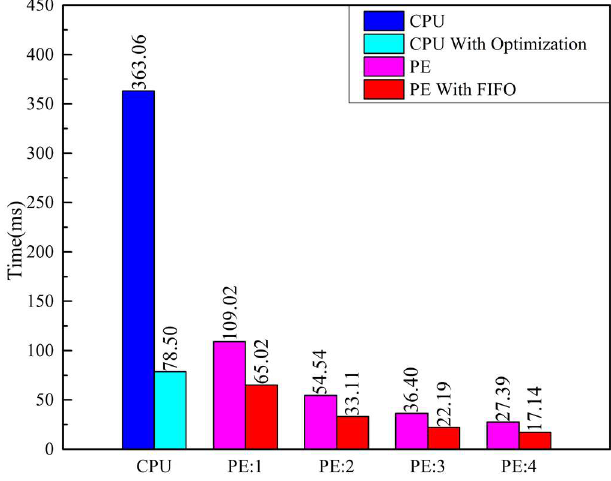
Figure 12. Time comparison chart with different methods.